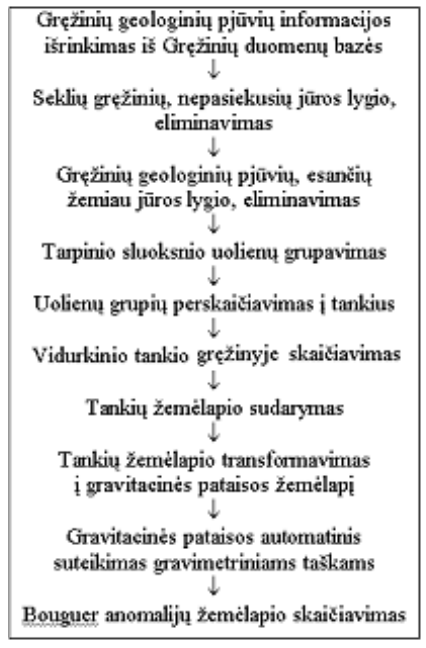
Fig 2. Flowchart of calculation of topography densities and Bouguer anomaly Tyrimams naudotasi Geologijos tarnyboje sukurta Gr ę žini ų duomen ų baze, kuri yra sud ė tin ė Valstybin ė